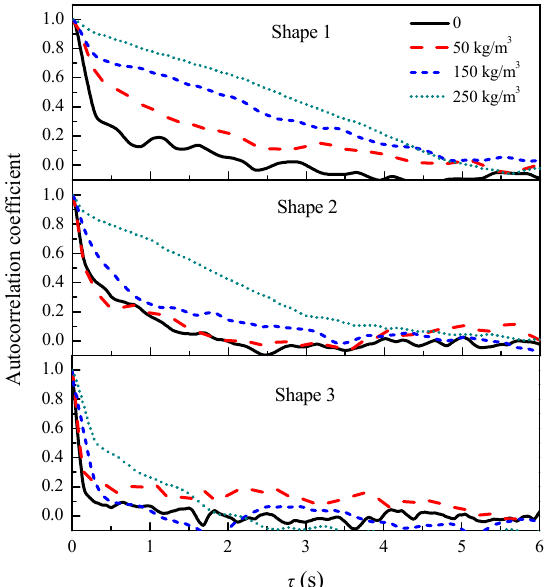
Figure 13. Profile of autocorrelation coefficient for various shapes in fresh water and sediment-laden flow at 2.20 m upstream with different sediment concentrations.